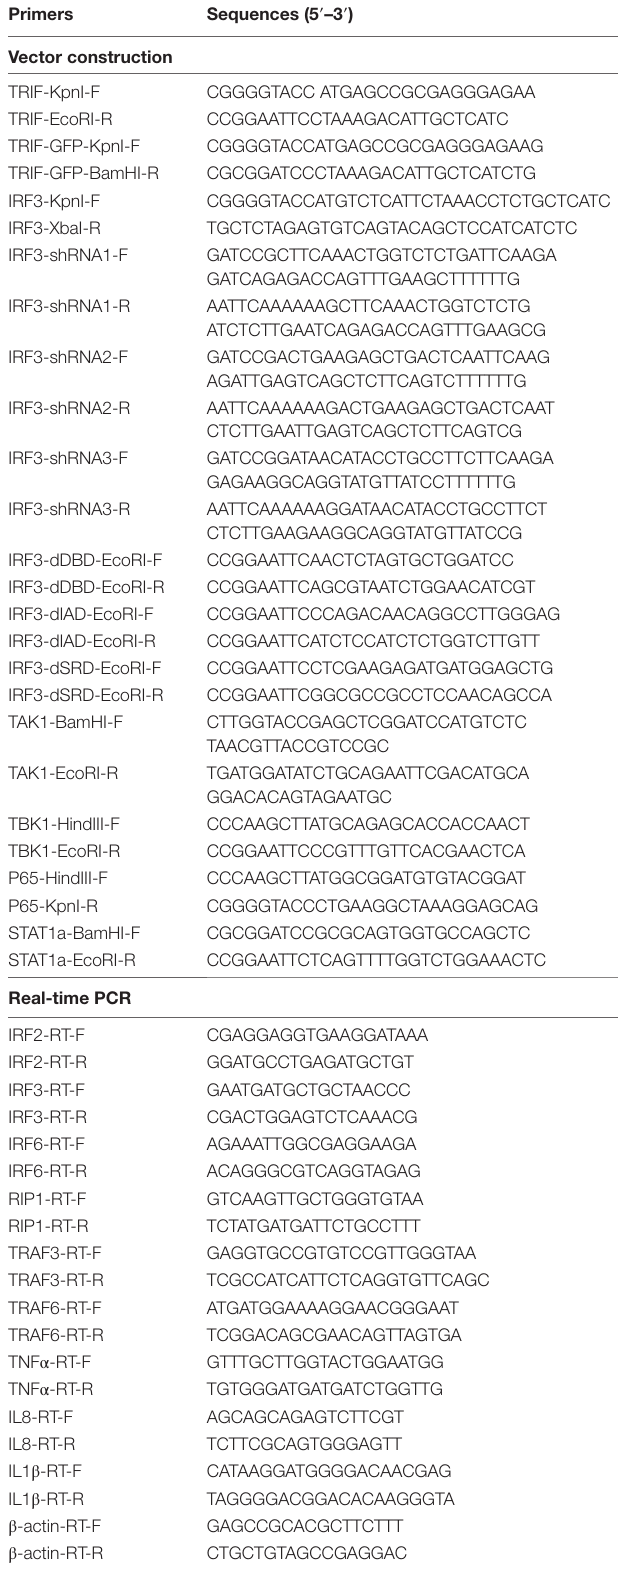
TaBle 1 | PCR primer sequence information in this